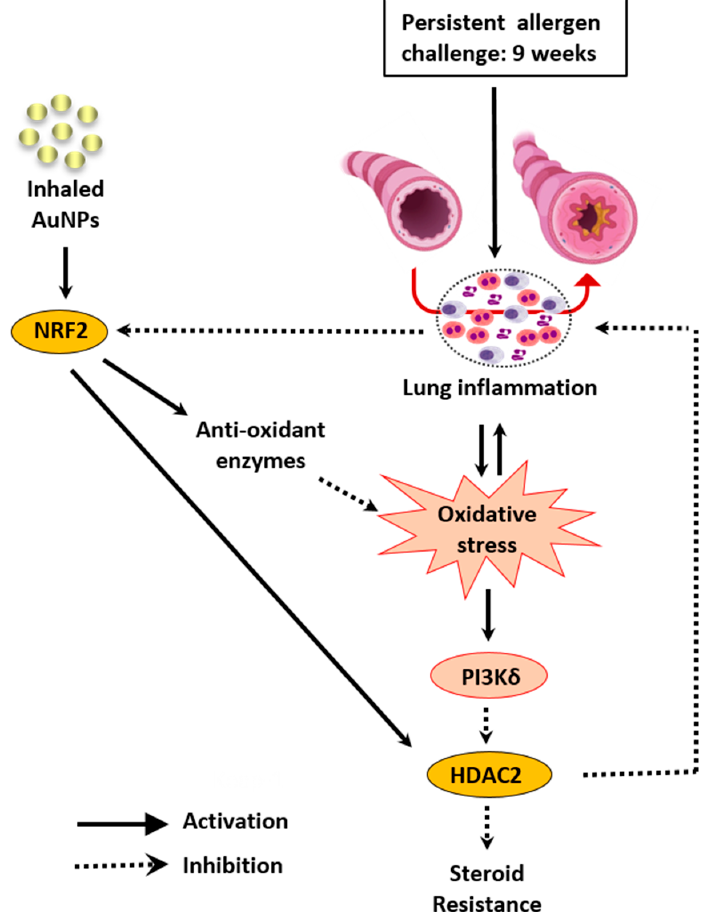
Figure 7. Schematic illustration of how gold nanoparticles (AuNPs) might be working in this murine model of glucocorticoid-insensitive asthma. Persistent allergen provocation of A/J mice causes chronic inflammation characterized by neutrophil and eosinophil infiltration, airway hyper-reactivity, mucus exacerbation, and lung remodeling. Oxidative stress via phosphoinositide 3-kinases δ (PI3K δ ) decreases GC sensitivity by down-regulating histone deacetylase 2 (HDAC2), a co-factor of glucocorticoid suppressive genomic action, which has a pivotal role in inhibiting allergen-induced lung inflammation. AuNPs can activate nuclear factor erythroid 2-related factor 2 (NRF2), whose expression appeared reduced in untreated and Budesonide-treated asthmatic mice but not in those asthmatic mice subjected to AuNP inhalation. Activation of NRF2 can up-regulate antioxidant enzymes and rescue HDAC2 baseline levels. Inhaled AuNPs decreased several steroid-insensitive asthma changes, including lung inflammation and adverse